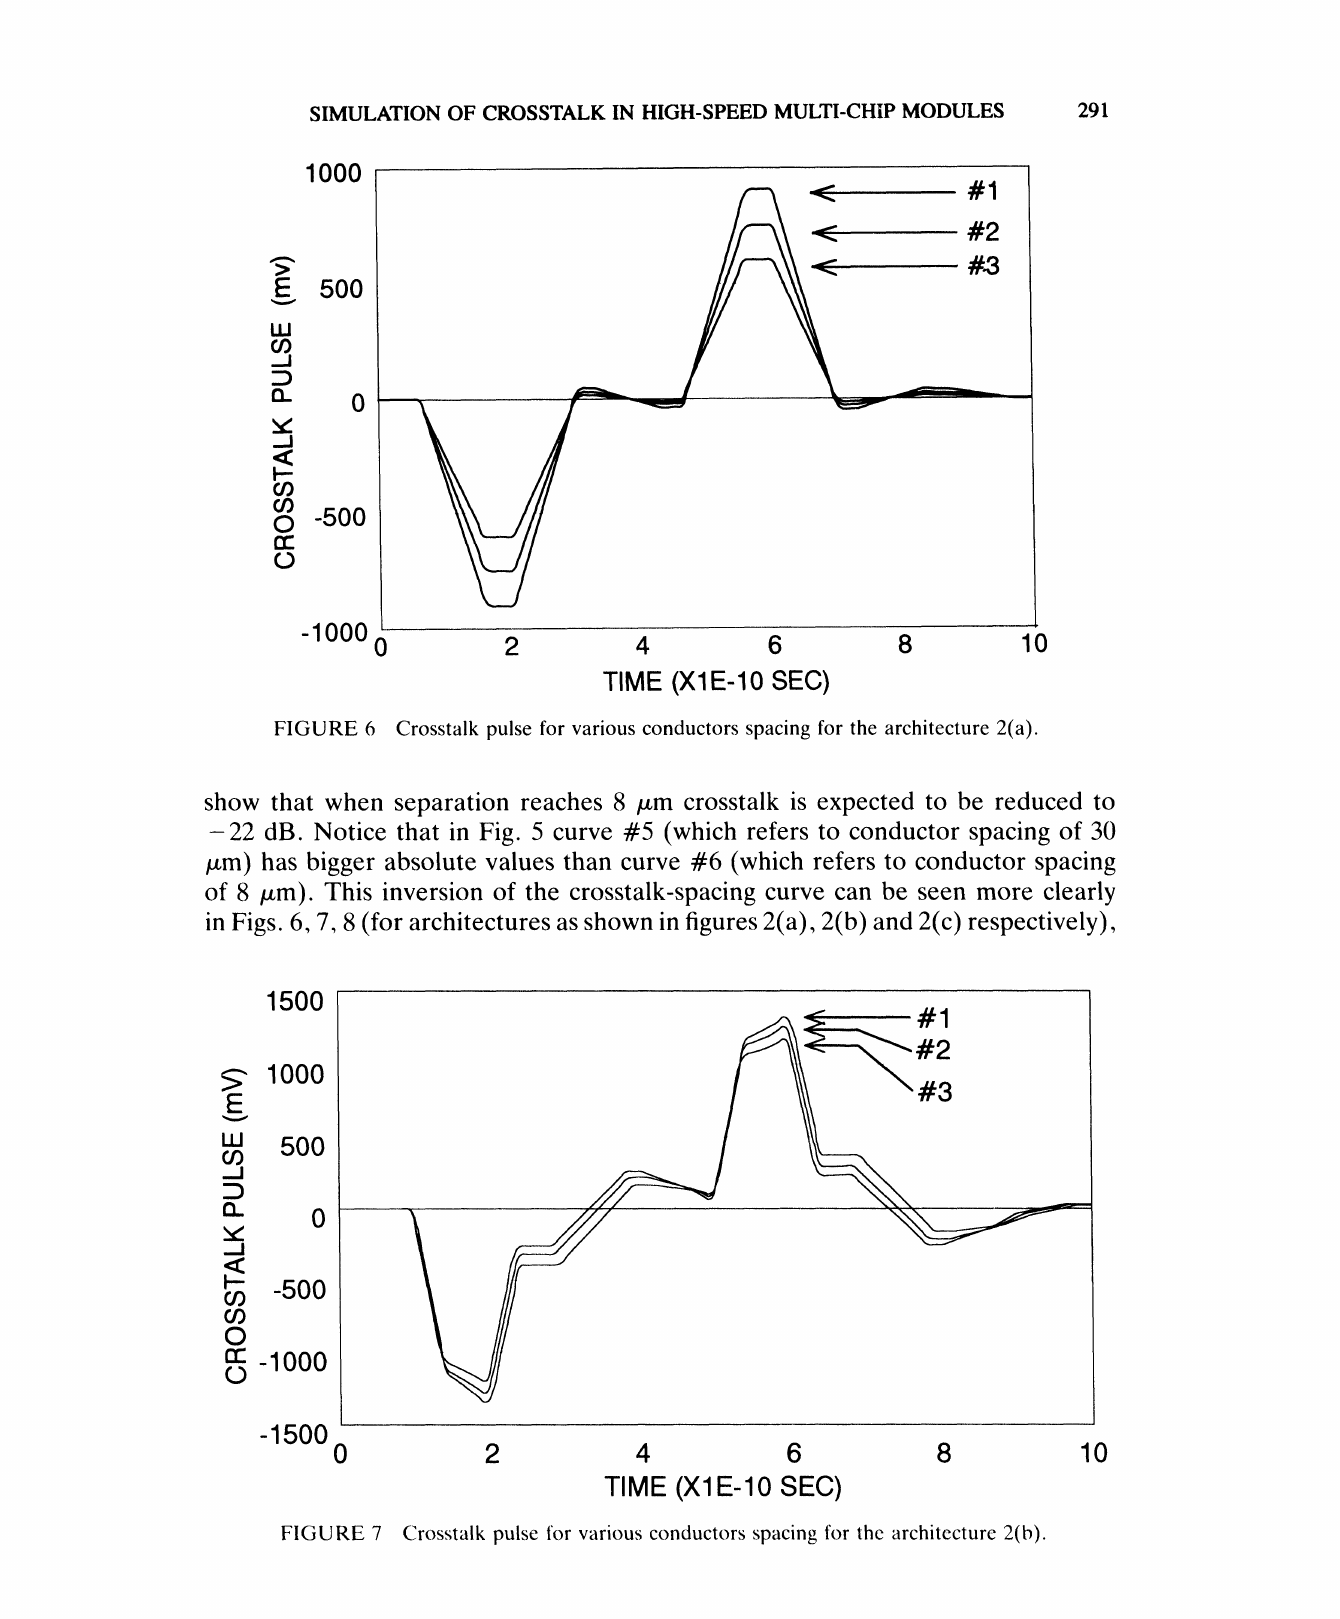
TIME (Xl E- 10 SEC) Crosstalk pulse for various conductors spacing for the architecture